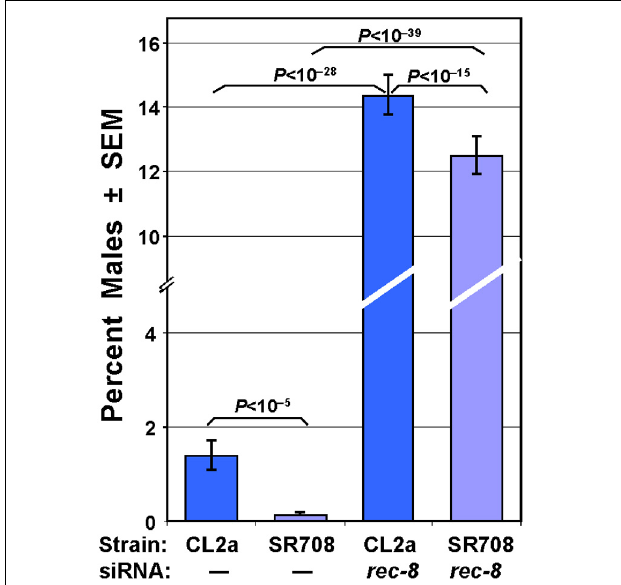
FIGURE 3 | Male frequency in the two lsq4 isogenic strains. The longer-lived lsq4 -isogenic strain, CL2a, has a significant HIM (high incidence of males) phenotype (two “ – ” bars on left). RNA interference targeting rec-8 greatly elevates the male frequency, but the difference between the two lsq4 -allelic strains was preserved (two “ rec-8 ” bars). N ranged from 1147–1920 progeny examined for male incidence per assessment. Data are shown for one of three experiments with similar